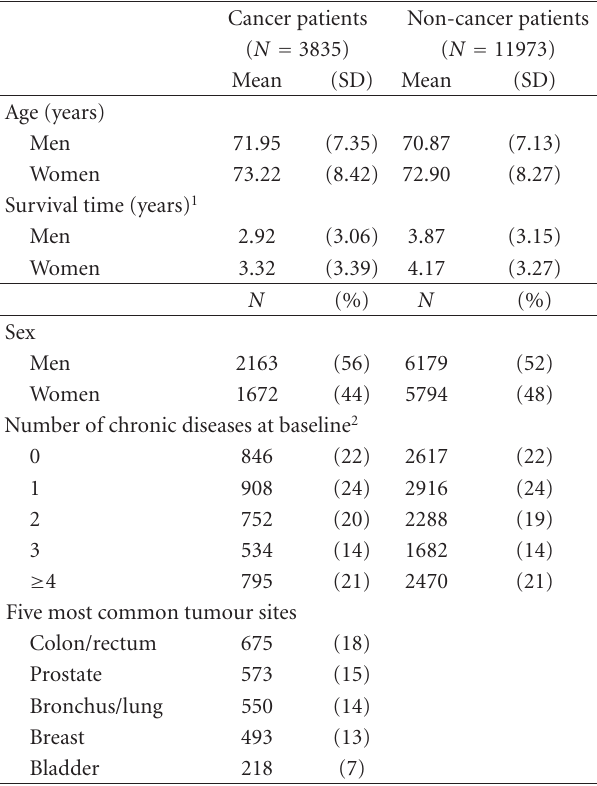
Table 1: Characteristics of older cancer patients and non-cancer patients at time of cancer diagnosis or reference